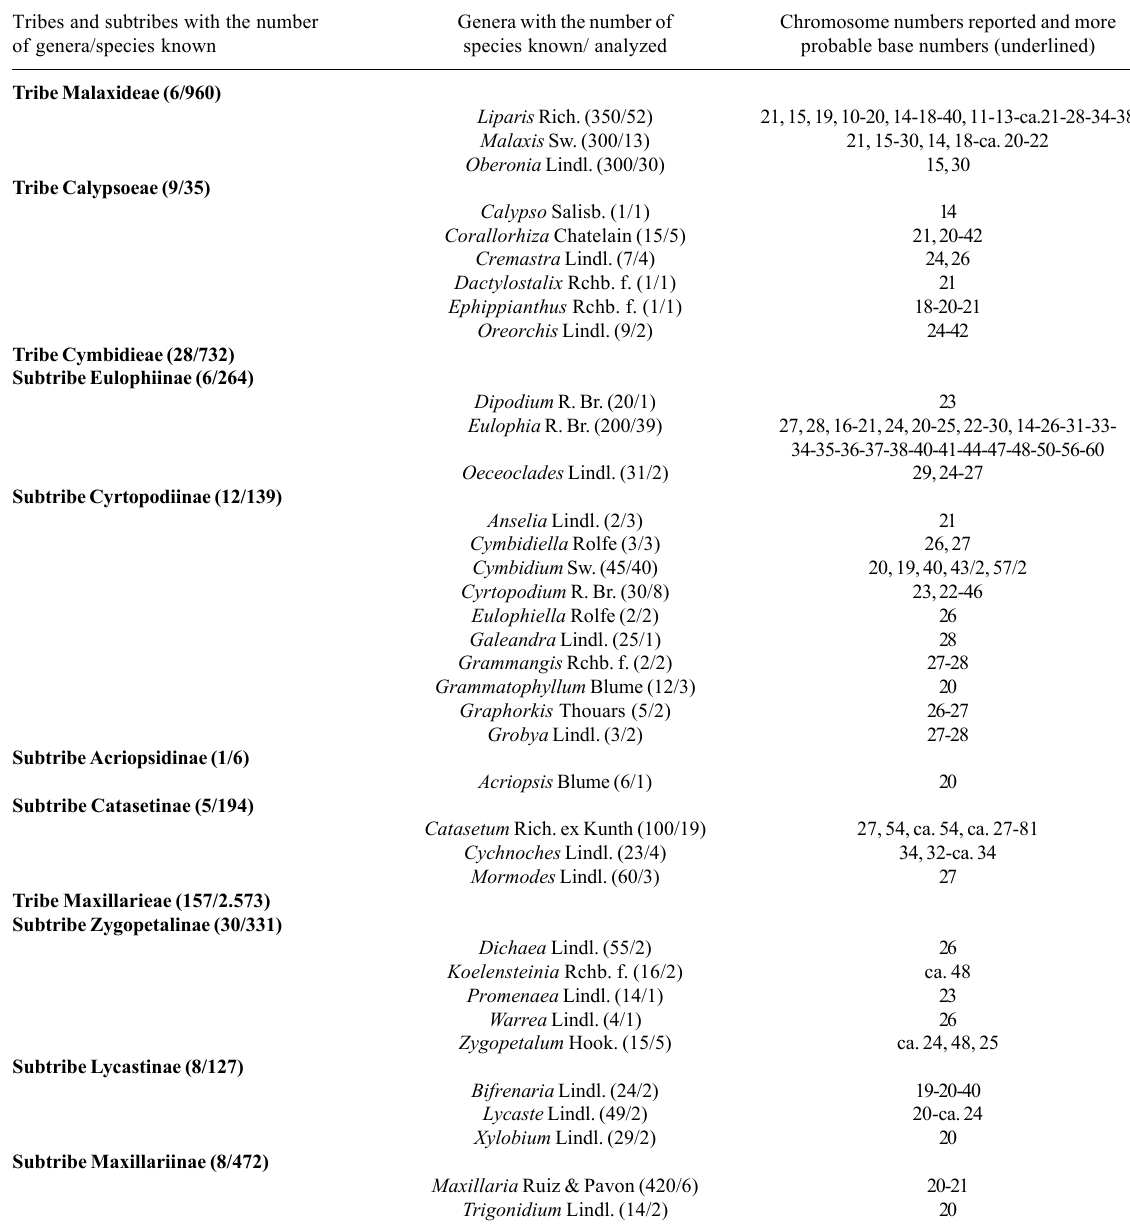
Table III - Chromosome numbers and probable base numbers of tribes, subtribes and genera of Cymbidioid ( sensu Dressler, 1993). Chromosome numbers are ordered from the more to the less frequent. Numbers conected with a line have equal frequencies. Tribes and subtribes with the number Genera with the number of Chromosome numbers reported and more of genera/species known species known/ analyzed probable base numbers